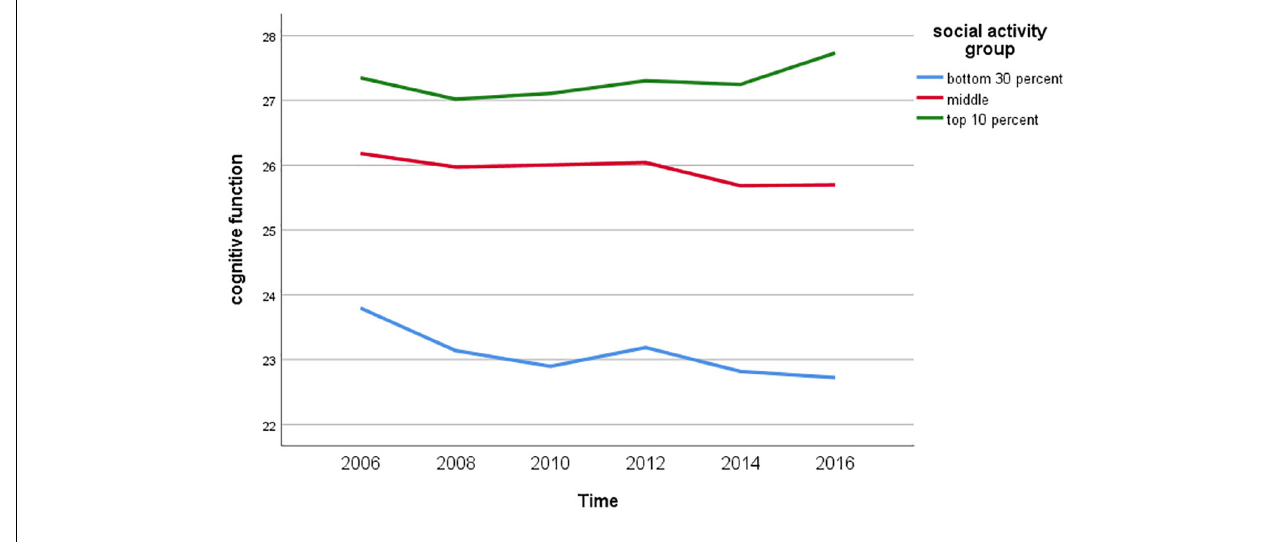
FIGURE 2 | Cognitive function according to the level of social activity.